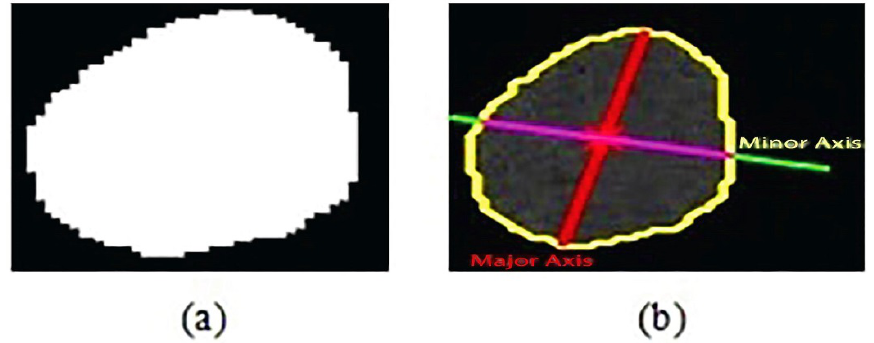
Figure 6. ( a ) Area of breast lesion; ( b ) minor axis and major axis. Table 4. Employed features description.